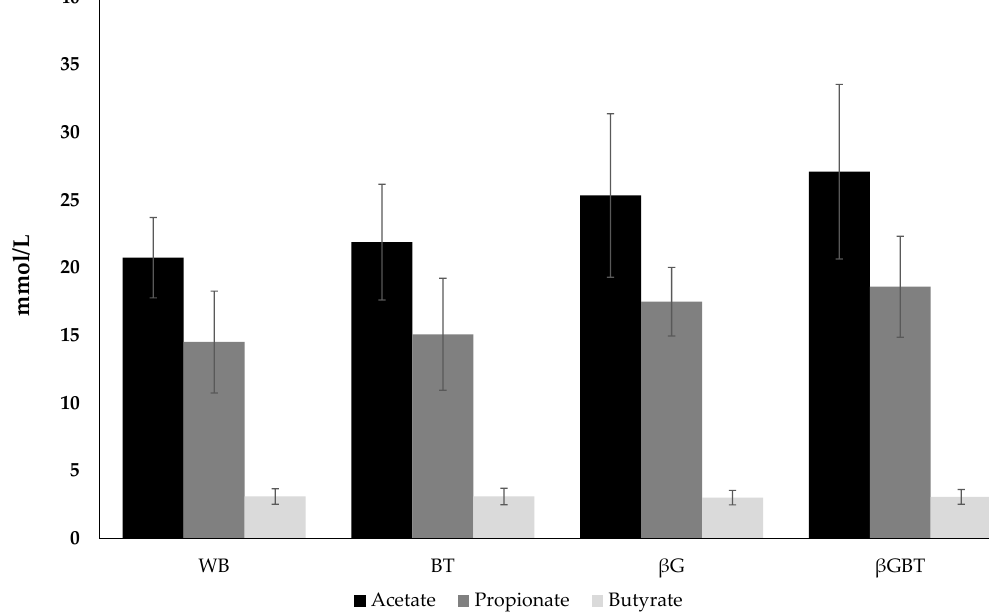
Figure 2. Production of SCFA (mmol/L) after 24 h fermentation of different breads after in vitro digestion. Results are mean (SD) ( n = 4 donors). WB, white bread; BT, black tea bread; β G, β -glucan bread; β GBT, β -glucan with black tea bread.